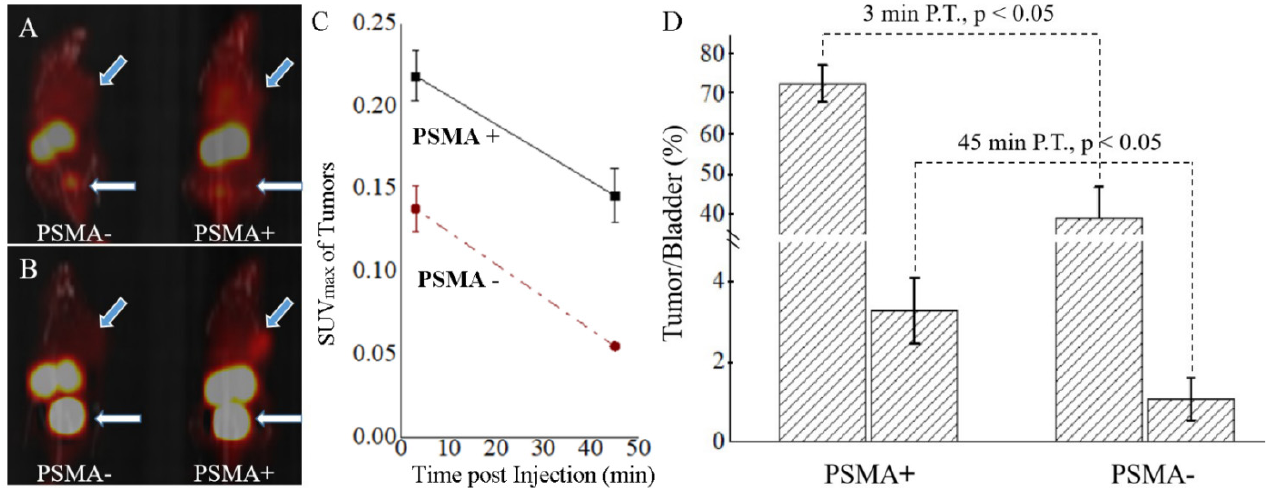
Figure 1. MIP images of PSMA-negative and PSMA-positive xenograft models that were acquired at 3 min ( A ) and 45 min ( B ) P.I., where blue arrows point to the xenografts, and white arrows point to the bladder. ( C ) The absolute values of tracer uptake at 3 and 45 min P.I.; the corresponding percentages for tumor to bladder ratios at 3 min P.I. and 45 min P.I. are summarized in columns ( D ).